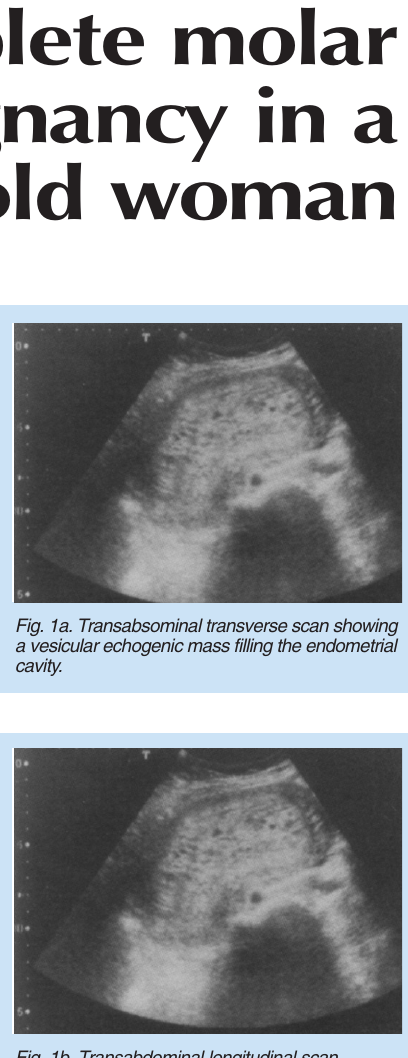
Fig. 1b. Transabdominal longitudinal